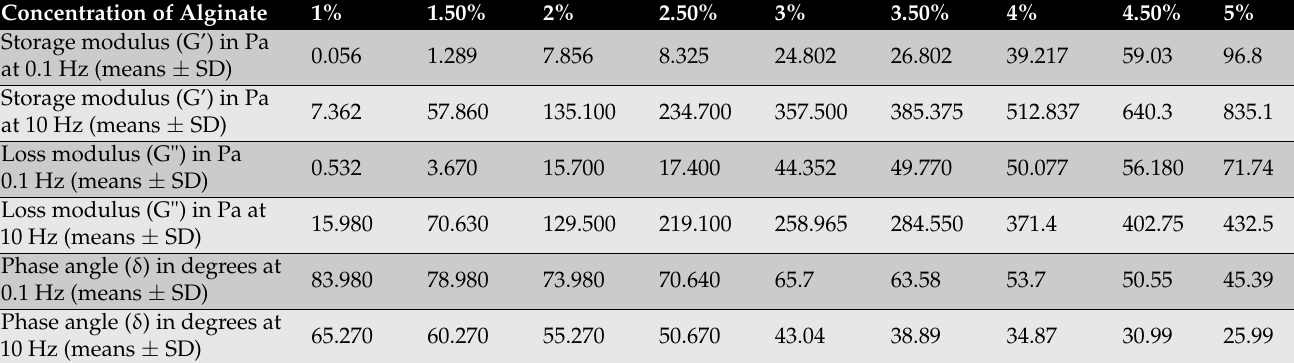
Table 1. Rheological parameters of different bioink formulations. The storage (G (cid:48) ) and loss (G”) moduli (in Pa) as well as phase angle values at the lowest (0.1 Hz) and highest (10 Hz) shear frequencies are